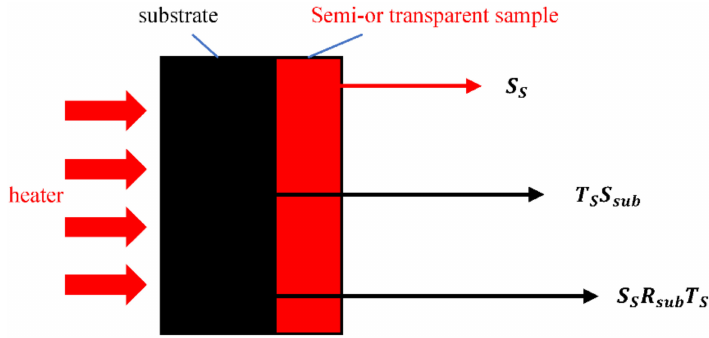
Figure 14. Schematic diagram of the double substrate method